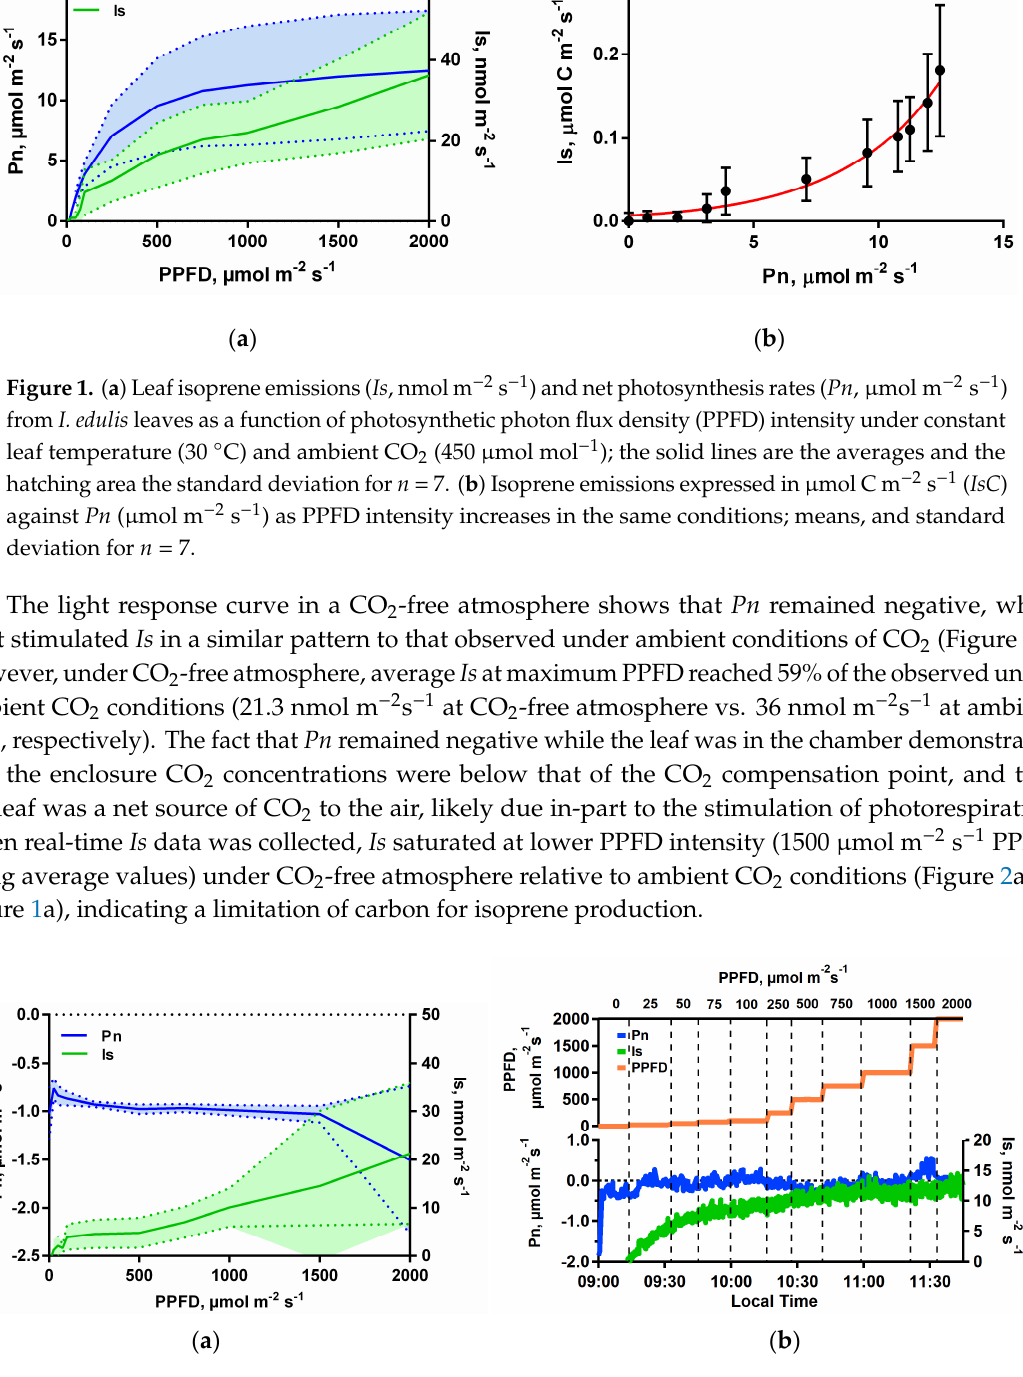
Figure 2. ( a ) Leaf isoprene emissions ( Is , nmol m −2 s −1 , measured by gas chromatography-mass spectrometry (GC–MS)) and net photosynthesis rates ( Pn , µmol m −2 s −1 ) from I. edulis leaves as a function of PPFD intensity under constant leaf temperature (30 °C) and CO 2 -free atmosphere (0 µmol mol −1 ). The solid lines are the averages and the hatching area the standard deviation ( n = 4); ( b ) Example of leaf isoprene emissions ( Is , nmol m −2 s −1 ) measured by high sensitivity quadrupole proton transfer reaction-mass spectrometry (PTR-MS) and net photosynthesis rates ( Pn , µmol m −2 s −1 ) from an I. edulis leaf under constants leaf temperature (30 °C) and CO 2 -free atmosphere, as a function of time with PPFD increases at the marked intervals.